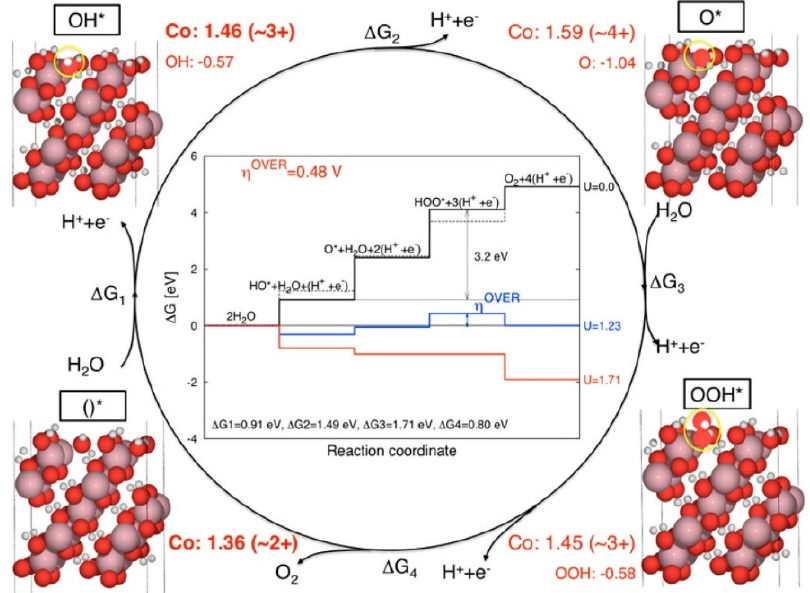
Figure 24. Schematic of the OER on the (101 ̅ 4) surface. The inset shows the free-energy landscape compared to an ideal catalyst (dashed-line) for zero pH. Reaction 3 is the potential-limiting step. For U > 1.71 V, all steps are thermodynamically accessible. (Reprinted from ref. [68] with permission from Journal of American Chemical Society. Copyright © 2013, American Chemical Society).